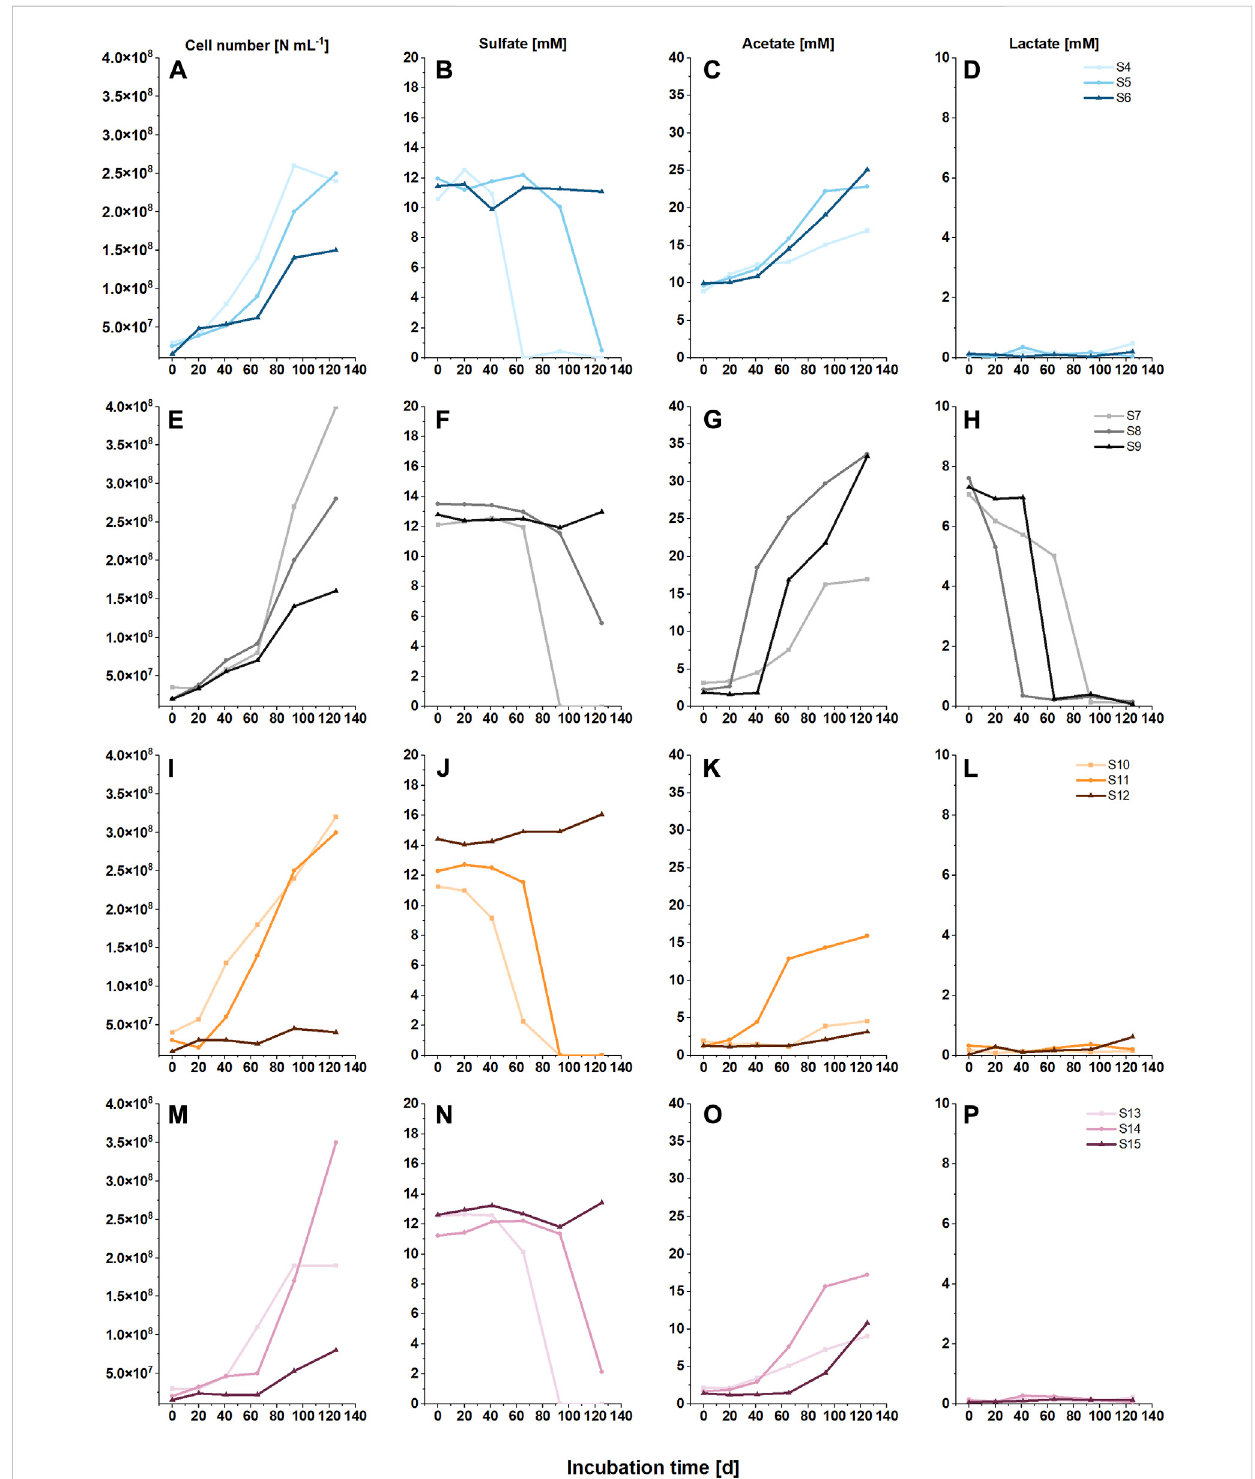
FIGURE 1 Cell numbers (A,E,I,M) and concentrations of sulfate (B, F, J, N) , acetate (C, G, K, O) and lactate (D, H, L, P) of microcosms with three salinity levels, indicated by different color shades (2.6 M NaCl, light; 3.4 M NaCl, normal; and 4.4 M NaCl, dark), with either acetate ( A, B, C, D , blue), lactate ( E, F, G, H , black), methanol ( I, J, K, L , orange) or no C source ( M, N, O, P , pink) and a H 2 :CO 2 gas (8:2)